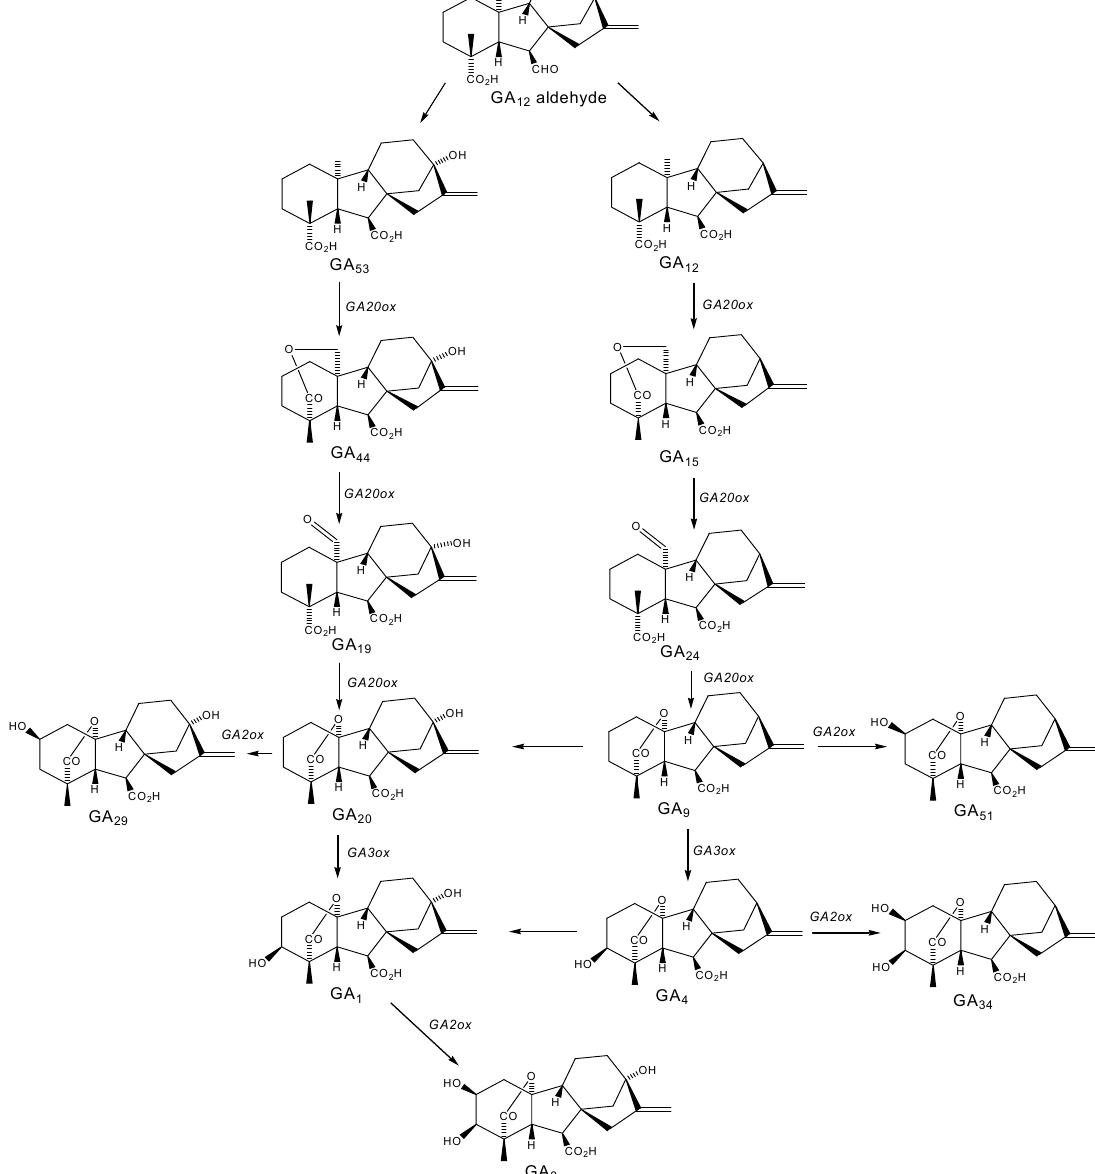
Figure 1. Pathways of gibberellin biosynthesis: two putative pathways of gibberellin biosynthesis, the early 13-hydroxylation and early non-hydroxylation pathways that are likely utilized in vegetative tissues of many higher plants [48,54,70]. The GA GA → GA conversions are based on a limited number of examples in the literature, and 4 1 thus may not be commonplace. Compliments of Ruichuan Zhang and Richard